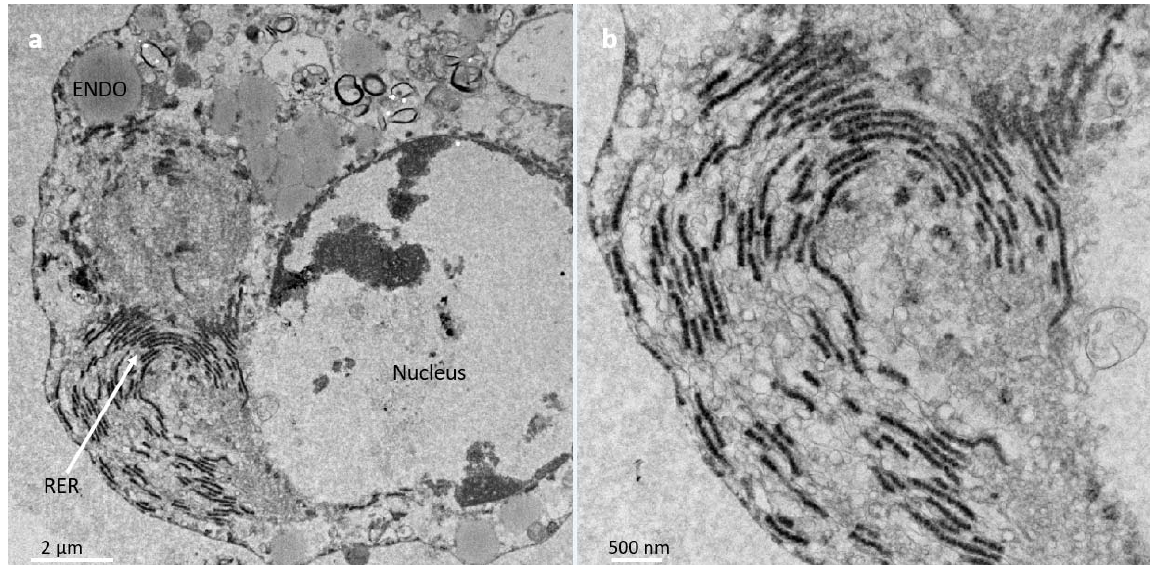
Figure 9. Transmission electron micrograph of a four-cell aggregate of BmVIII-SCC cells from 85-day culture on gelatinous beads in a bioreactor. SMG: small granular cell; ENDO: endosome; NM: nuclear membrane; GM: vesicle granular material. Scale bar = 2.8 μ m.